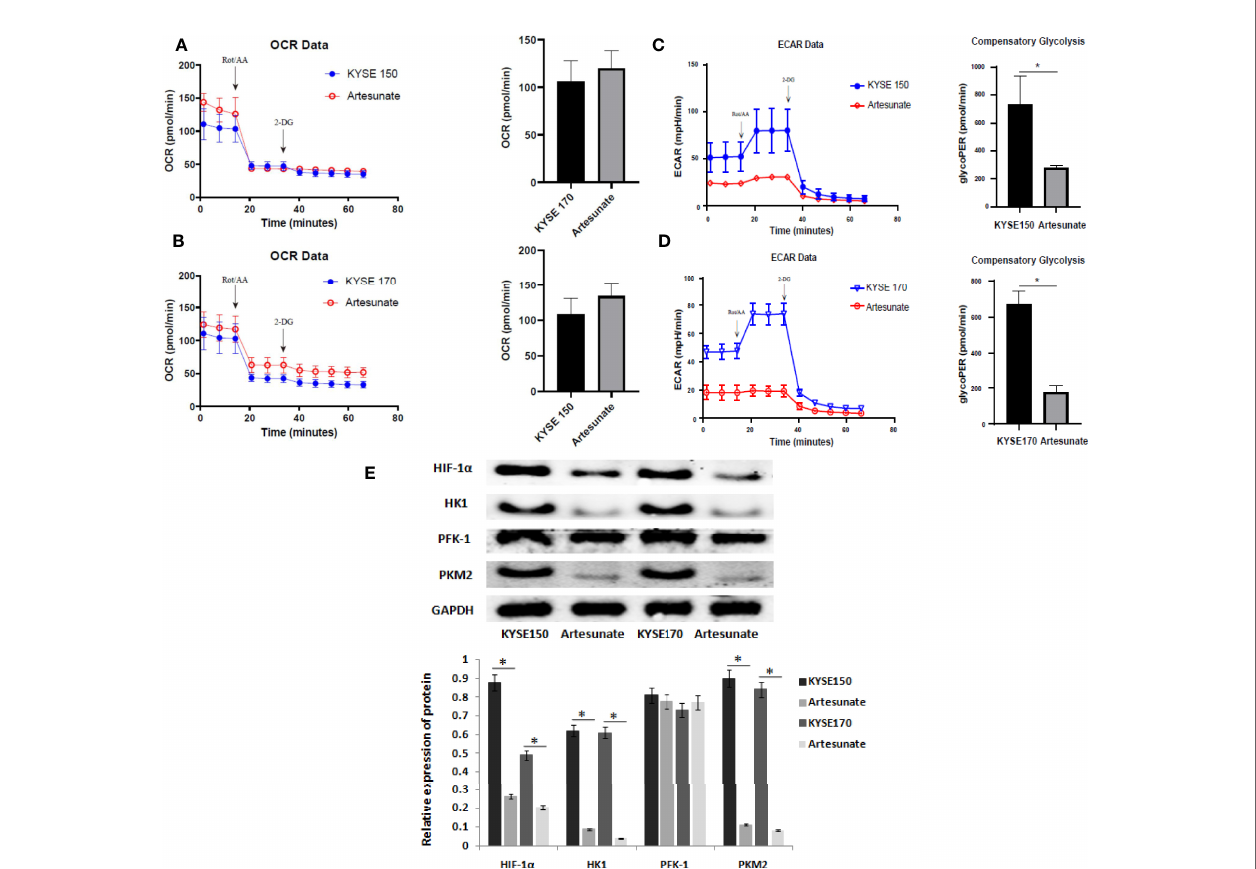
FIGURE 3 | Artesunate inhibits glycolysis in EC cells. (A) The effect of artesunate on the mitochondrial metabolism rate was tested by OCR in KYSE150 cells. (B) The effect of artesunate on the mitochondrial metabolism rate was tested by OCR in KYSE170 cells. (C) The effect of artesunate on the glycolysis rate was tested by ECAR in KYSE150 cells. (D) The effect of artesunate on the glycolysis rate was tested by ECAR in KYSE170 cells. (E) The levels of key enzymes of glycolysis were tested by Western blotting. *P <